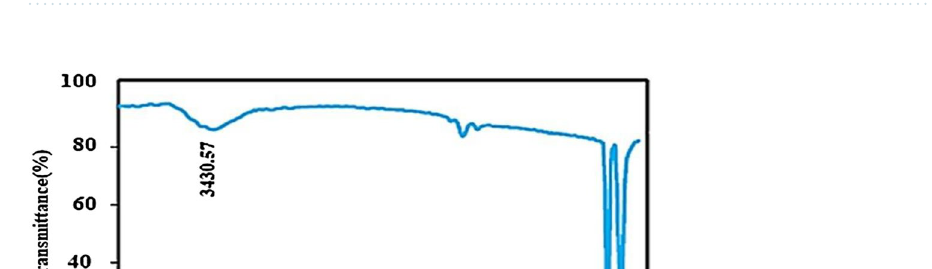
Figure 6. XRD analysis of green synthesized Cr 2 O 3 nanoparticles.